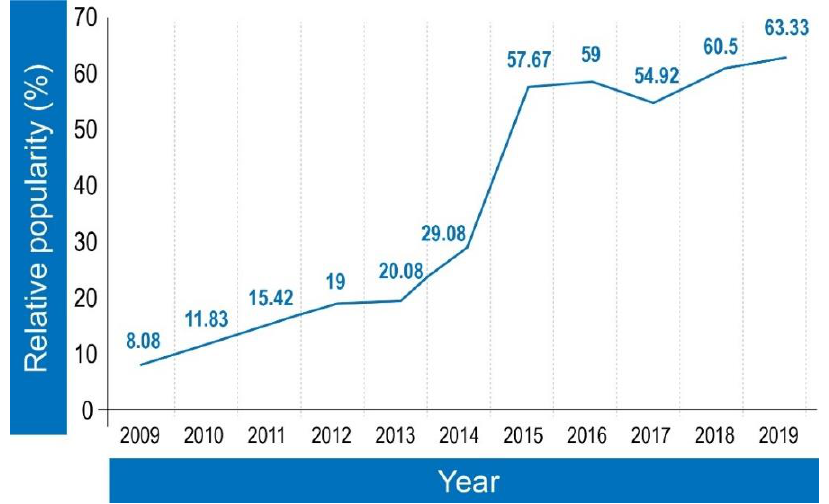
Figure 3. Volume of publications on smart cities (2009 – 2019). Source: [10]. Adapted by the